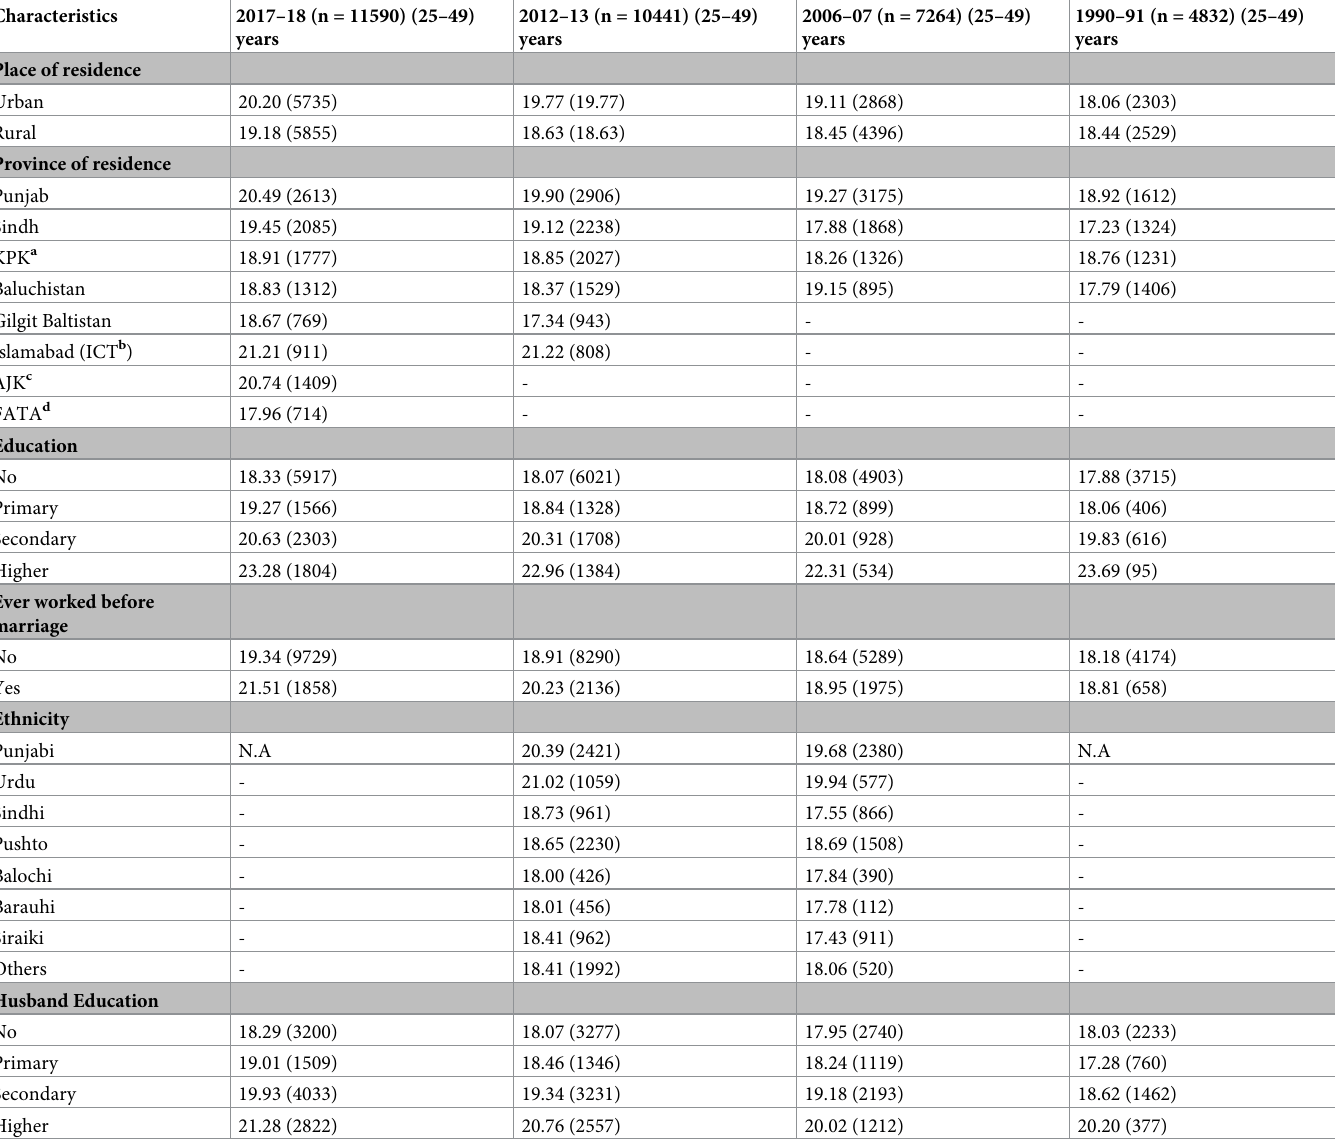
Table 4. Mean age at first marriage of currently married women by various characteristics, Pakistan, 1990 to 2018: Four Pakistan Demographic and Health Surveys (PDHSs) (1990–91, 2006–07, 2012–13 and 2017–18).